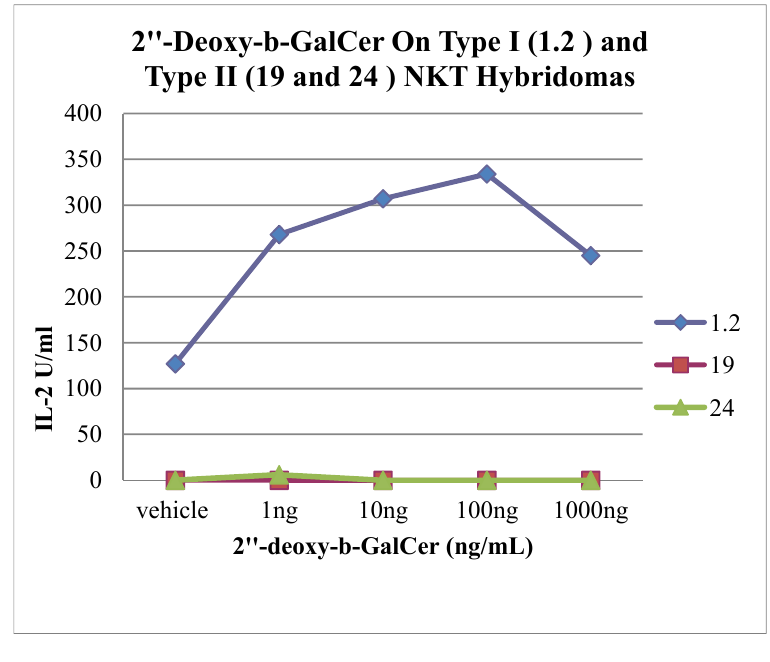
Figure 3. Type I and Type II NKT cell hybridoma responses to 2 ꞌꞌ -deoxy- β -GalCer 2